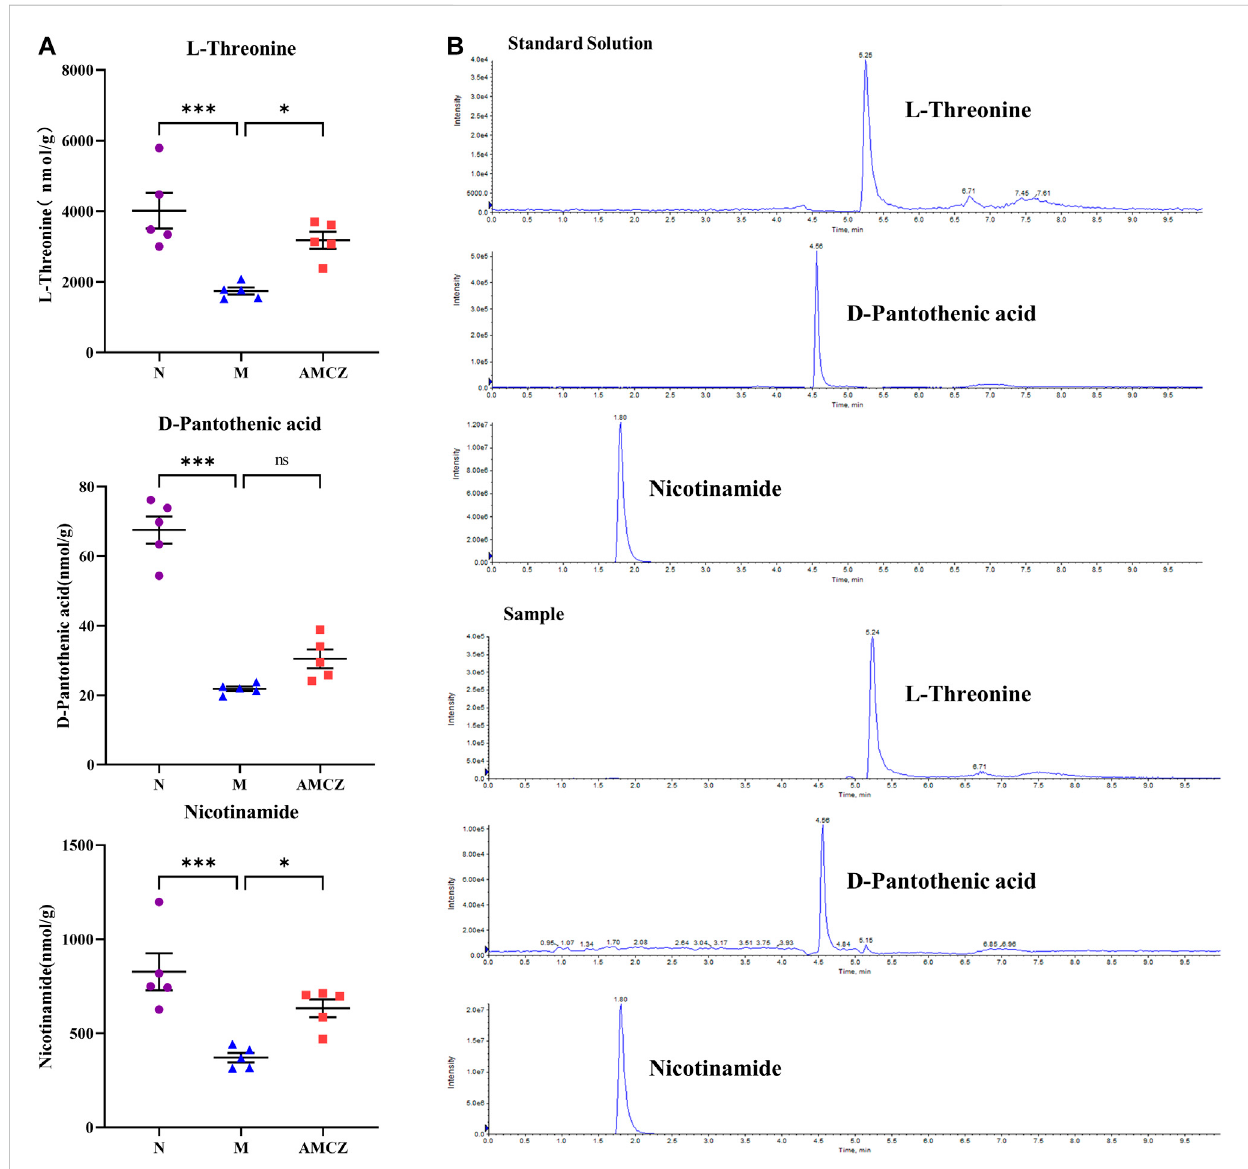
FIGURE 9 AMandCZupregulationtheconcentrationofL-Threonine,D-pantothenicacid,andnicotinamide. (A) TheconcentrationofL-Threonine,D-pantothenicacid, and nicotinamide in three groups (n = 5). Data are presented as the means ± SEM (*** p < 0.001, * p < 0.05). (B) The extracted ion chromatographs (EICs) from a standard solution, and a sample of the targeted analytes under optimal conditions.